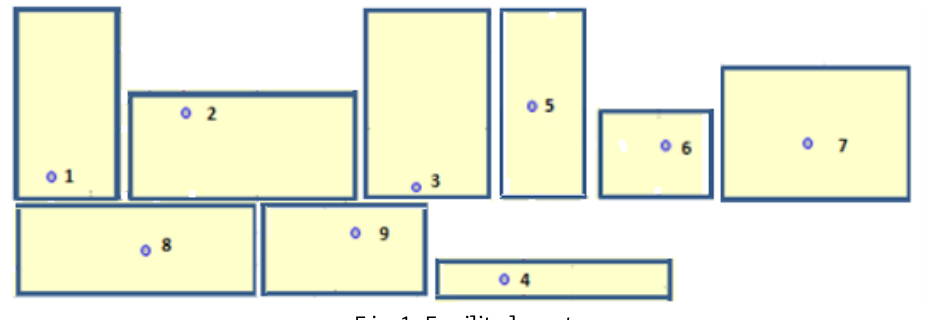
Fig. 1. Facility layouts